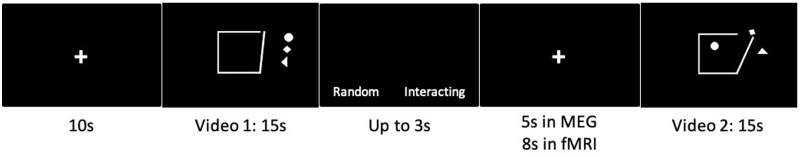

Social attribution task protocol. A 10-s baseline was presented at the beginning of each run. Each 15-s video was then presented. Participants were then given 3 s to respond to whether the shapes were moving randomly (physical condition) or interacting (social condition) followed by an inter-stimulus interval. The protocol was the same in MEG and fMRI, except in the fMRI the inter-stimulus interval was 8 s, whereas it was 5 s in the MEG. Task was designed by Klin (2000) and Schultz et al. (2003).